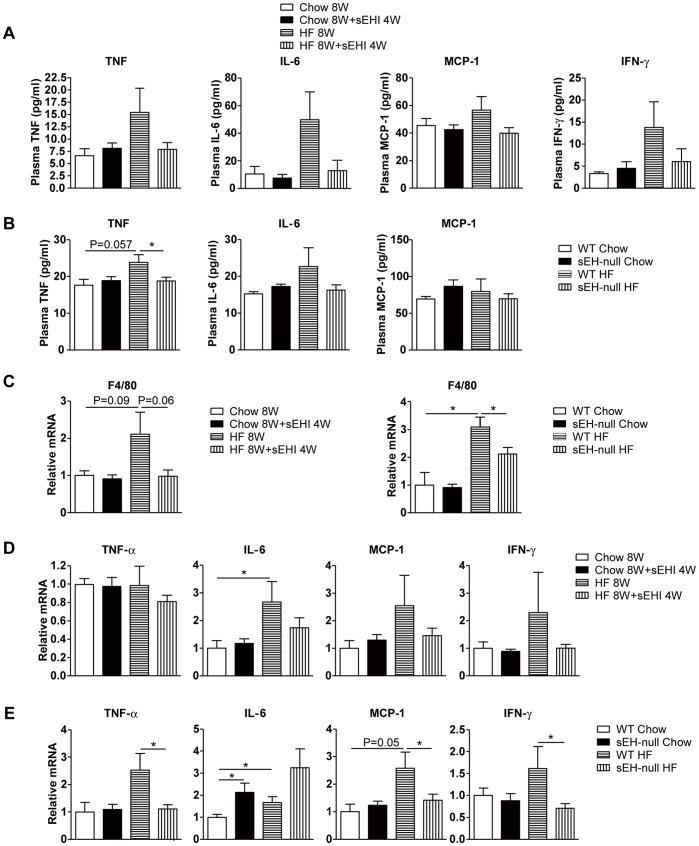
sEH inhibition or deficiency could block 8-week HF-diet–induced inflammation.(A) Proinflammatory cytokine levels in plasma of mice fed an 8-week chow or HF diet with or without 4-week t-AUCB. (B) Proinflammatory cytokine levels in plasma of WT and sEH-null mice fed an 8-week regular chow or HF diet. (C) mRNA levels of macrophage marker F4/80 in epididymal fat tissue. mRNA levels of tumor necrosis factor α (TNF-α) and interleukin 6 (IL-6), interferon γ (IFN-γ), monocyte chemoattractant protein 1 (MCP-1) in epididymal fat tissue of (D) mice fed an 8-week chow or HF diet with or without 4-week sEH inhibitor and (E) WT or sEH-null mice fed a chow or HF diet. Data are mean ± SEM. (* P<0.05, ** P<0.01).